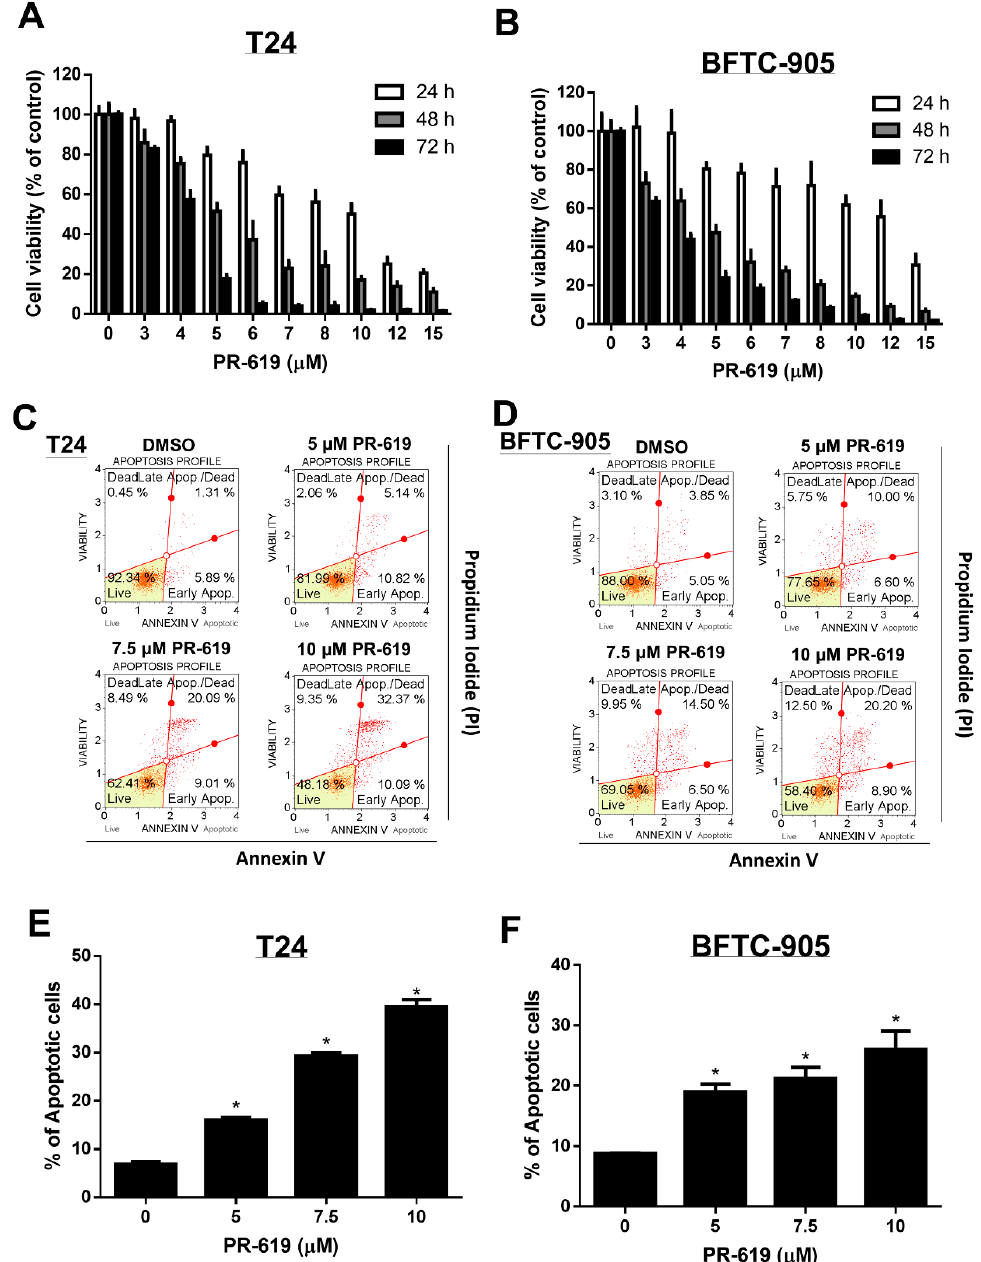
Figure 1. PR-619 induced cytotoxicity and apoptosis in human urothelial carcinoma cells in a dose-dependent and time-dependent manner. ( A ) T24 and ( B ) BFTC-905 cells were treated with various concentrations of PR-619 (3–15 μ M) for 24 h, 48 h, and 72 h, respectively. Cell viability was assessed using the 3-(4,5-dimethylthiazol-2-yl)-2,5-diphenyltetrazolium bromide (MTT) assay. ( C ) T24 and ( D ) BFTC-905 cells were exposed to PR-619 (5, 7.5, and 10 μ M) or DMSO for 24 h. Apoptotic cells were analyzed through FACS flow cytometry with propidium iodide and annexin V-FITC staining. ( E ) and ( F ) show the quantitative analyses of apoptosis presented as the means ± SD; * p < 0.05 compared with controls. All results shown are representative of at least three independent experiments.